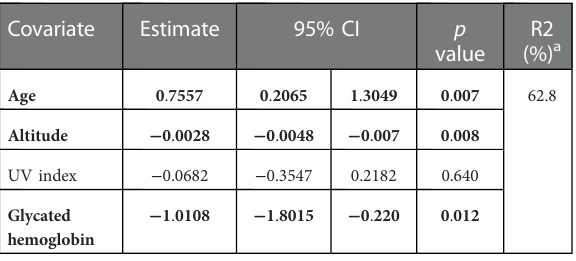
TABLE 4 Multivariate meta-regression analysis of intrinsic and extrinsic determinants for tOC in T1D a . Covariate